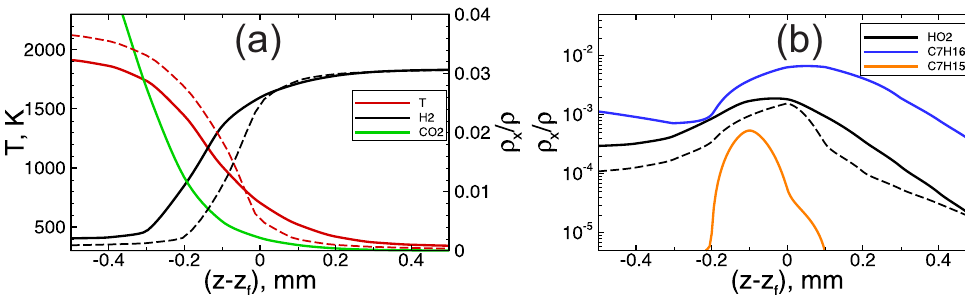
Figure 5. Temperature ( a ) and active radicals (( a )—H 2 and CO 2 , ( b )—HO 2 , C 7 H 16 and C 7 H 15 ) profiles in the vicinity of the flame front ( z = z f ). Dashed lines—hydrogen microfoam, 0.5H 2 + O 2 mixture. Solid lines—foamed emulsion with 0.5 vol.% of heptane in the emulsion foamed with 0.5H 2 + O 2 mixture.